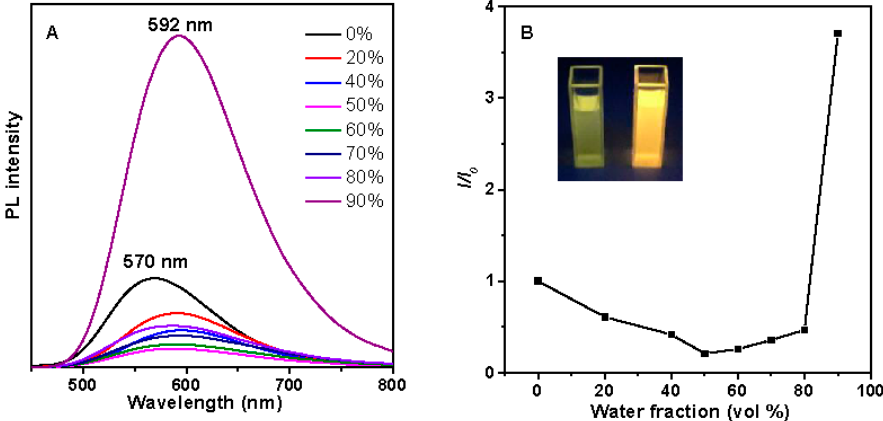
Figure 3. ( A ) The UV–vis and PL spectra in diluted THF solution of SFC, trans -DFC and cis -DFC (concentration: 1 × 10 − 5 mol L − 1 ); ( B ) The UV–vis and PL spectra in films of SFC, trans -DFC, and cis -DFC.